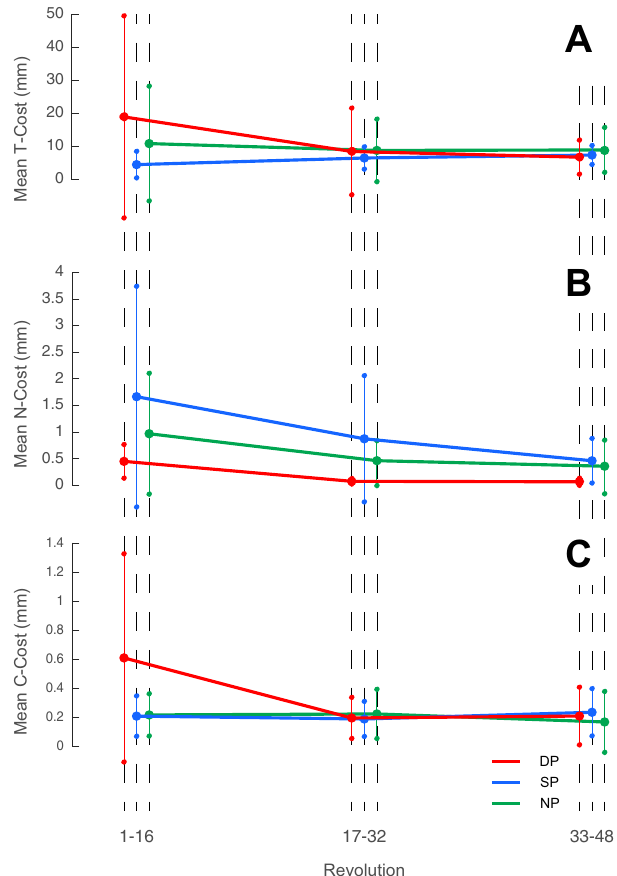
Figure 9. TNC-cost throughout performance. Results for the tolerance ( A ), noise ( B ), and covariance ( C ) costs throughout the performances for each group. While for the DP group it is possible to see that all costs reduce throughout the performance, for the SP group, only noise shows a very big reduction is visible whereas the tolerance and covariance remain relatively stationary.